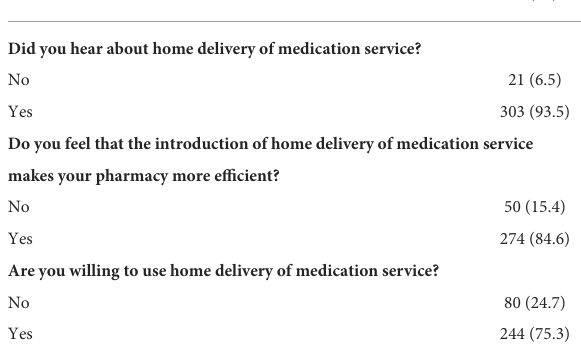
TABLE 2 Pharmacists’ awareness, opinion, and willingness to use home delivery of medications ( n = 324). Parameter